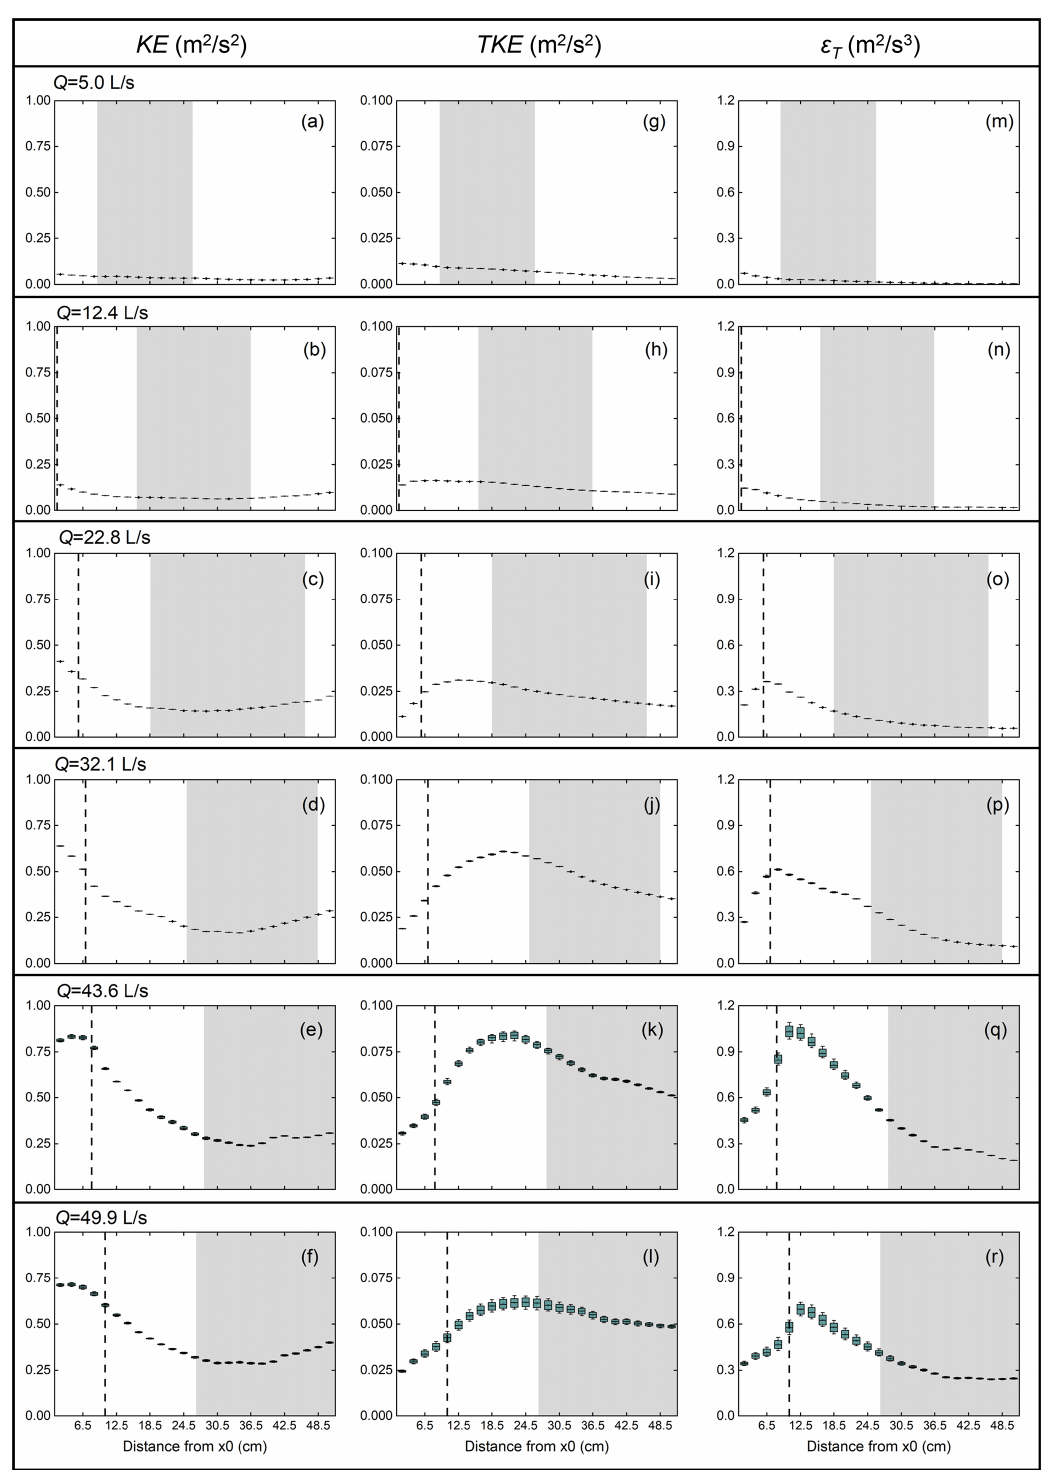
Figure 7. Box plots for the distributions of the mass-averaged flow kinetic energy (KE, panels a–f ), turbulence kinetic energy (TKE, panels g–l ), and turbulent dissipation ( ε T , panels m–r ) in the pool over 30s for all six tested discharges (the plots at the same discharge are in the same row). The mass-averaged values were calculated every 2cm in the streamwise direction. The flow direction is from left to right in all the plots. The general locations of the contraction section for all the flow rates are marked by the dashed lines, except for Q = 5Ls − 1 when the jump is located too close to the step. The longitudinal distance taken up by negative slope for the inspected range is shown by the shaded area in each plot. Earth Surf. Dynam., 10, 1253–1272,